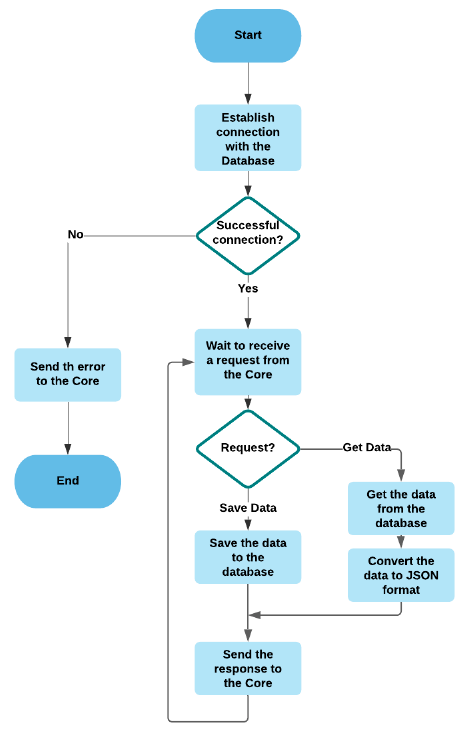
Figure 18. The flowchart of the database module.